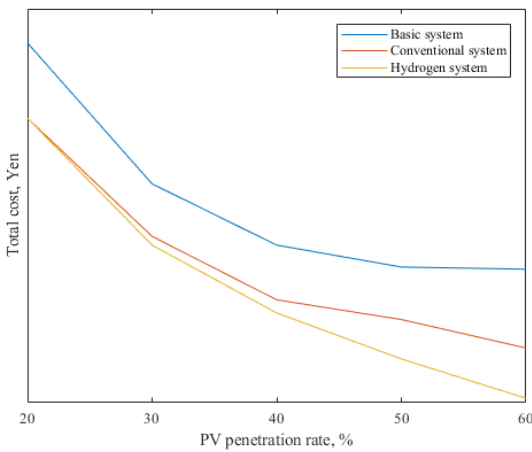
Figure 10. Benefits of different PV penetration rates (carbon tax:15 Yen/kgCO 2 ).